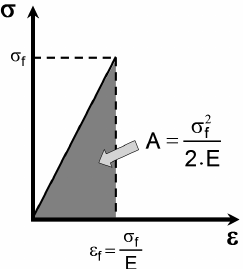
Figure 1. Stress-strain curve of a perfect brittle linear elastic specimen submitted to a catastrophic failure.